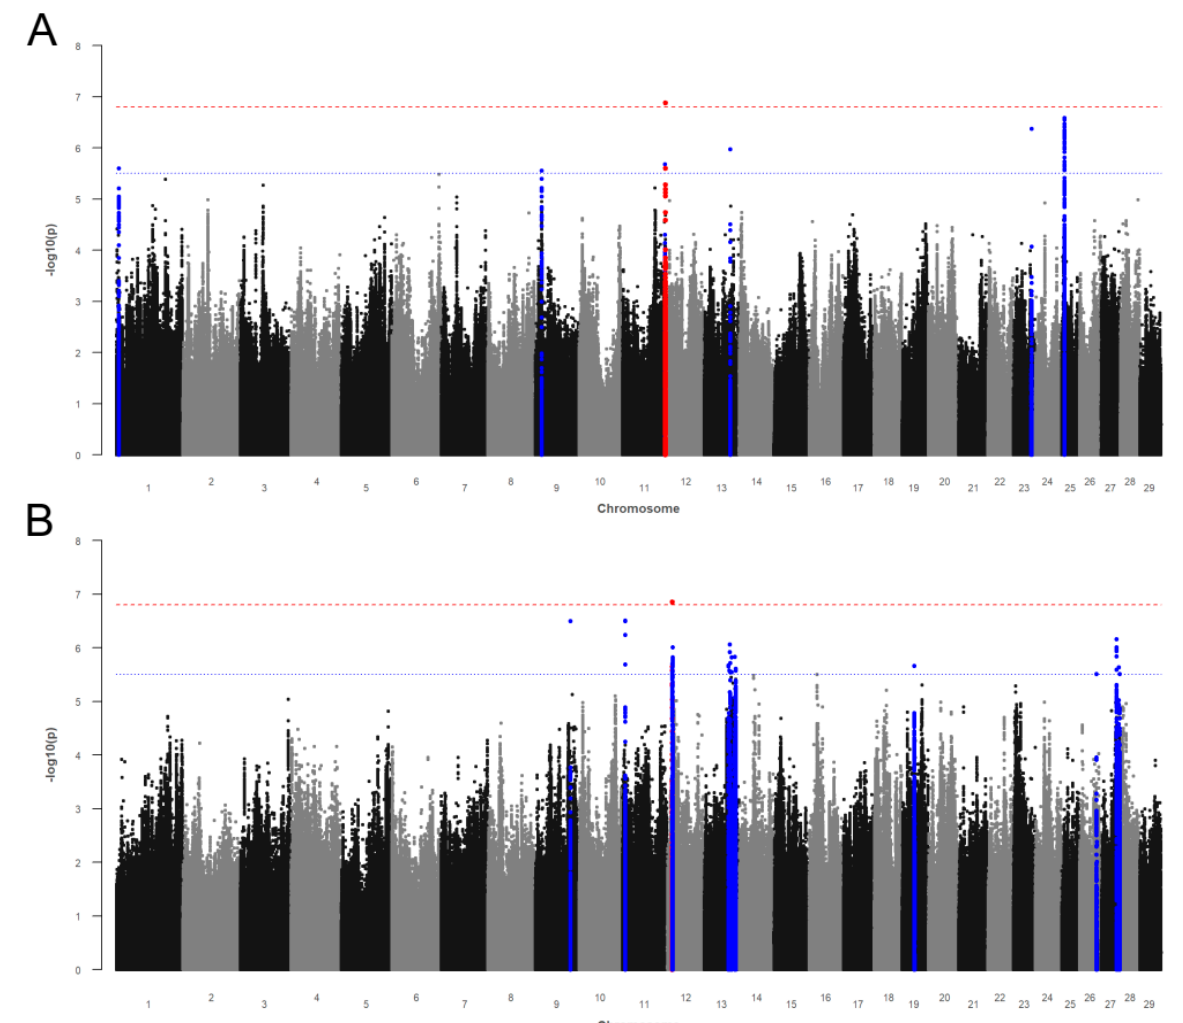
Figure 2. Manhattan plots for − log10 p -values of marker effects for (A) somatic cell score (SCS) and (B) fat-to-protein ratio (FPR). Markers above the genome-wide significance threshold p Bonf (red dashed line) are highlighted in red and markers above the suggestive significance threshold p Sug (blue dashed line) are highlighted in blue. Markers within a distance of 125 kb up- and downstream of the significantly or suggestively associated SVs are highlighted in red or blue, respectively.